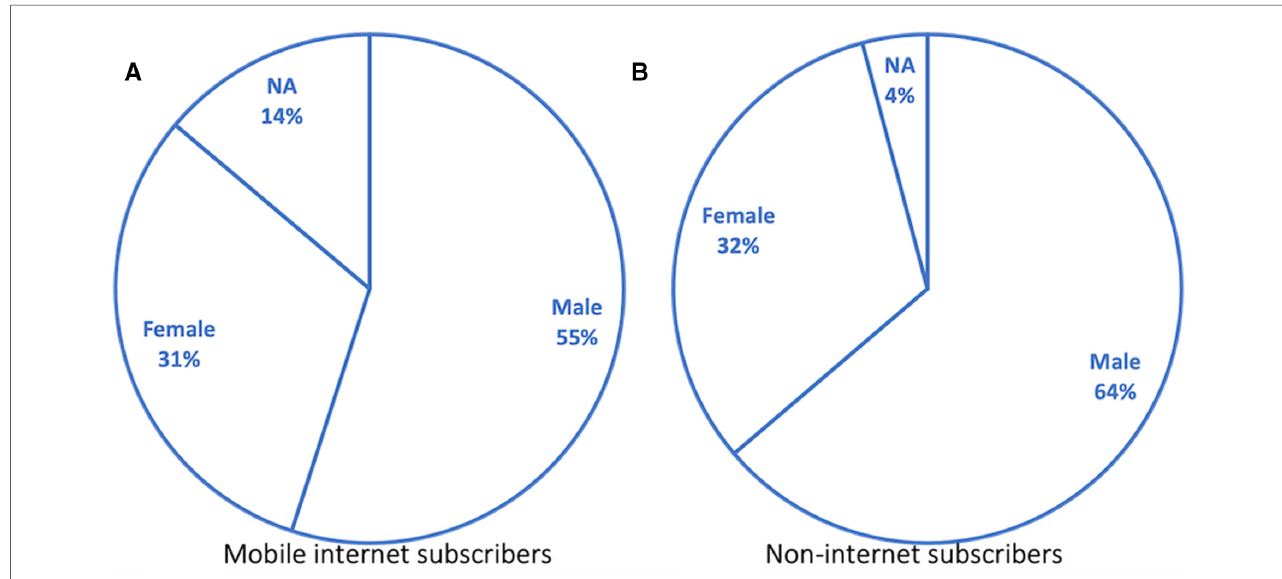
FIGURE 7 Distribution of targeted subscribers by sex (pilot